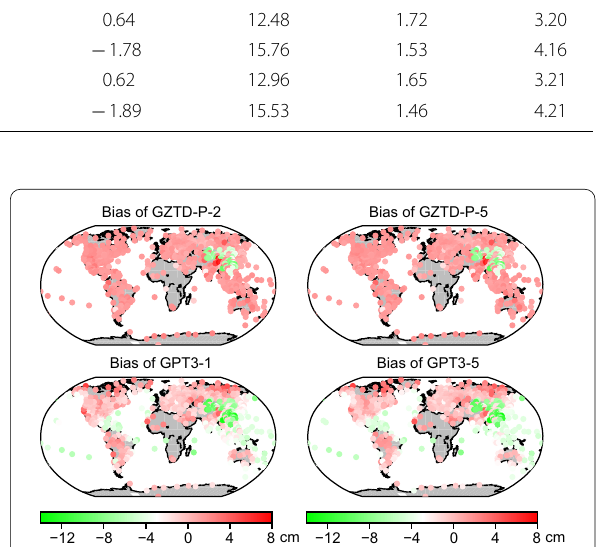
Fig. 9 Bias of the GZTD-P model and GPT3 model with different resolutions in the ZTD vertical interpolation of radiosonde over the